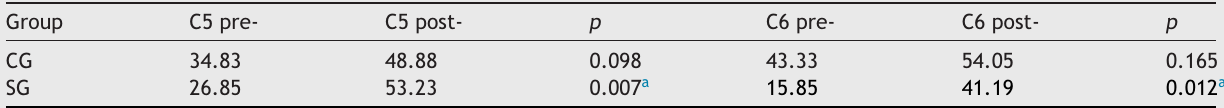
Mean values for C5 and C6 before and after training in the CG and